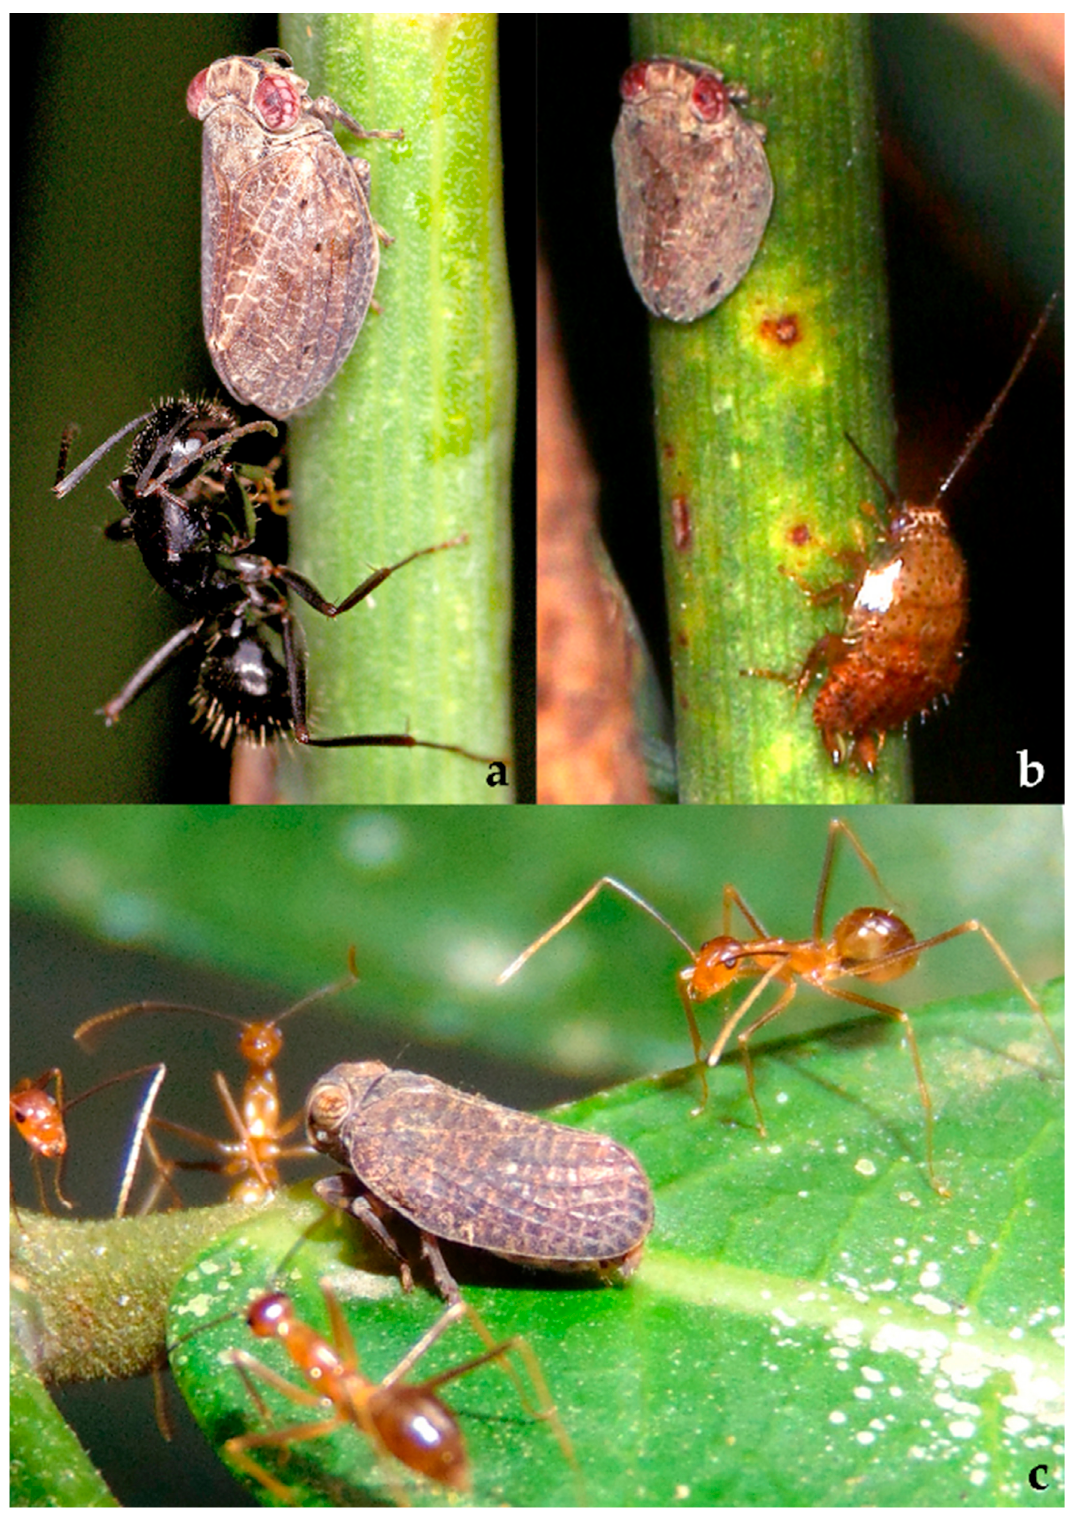
Figure 21. Issidae: ( a ) Hysteropterum sp. tended by Formicidae: Formicinae: Camponotus aethiops